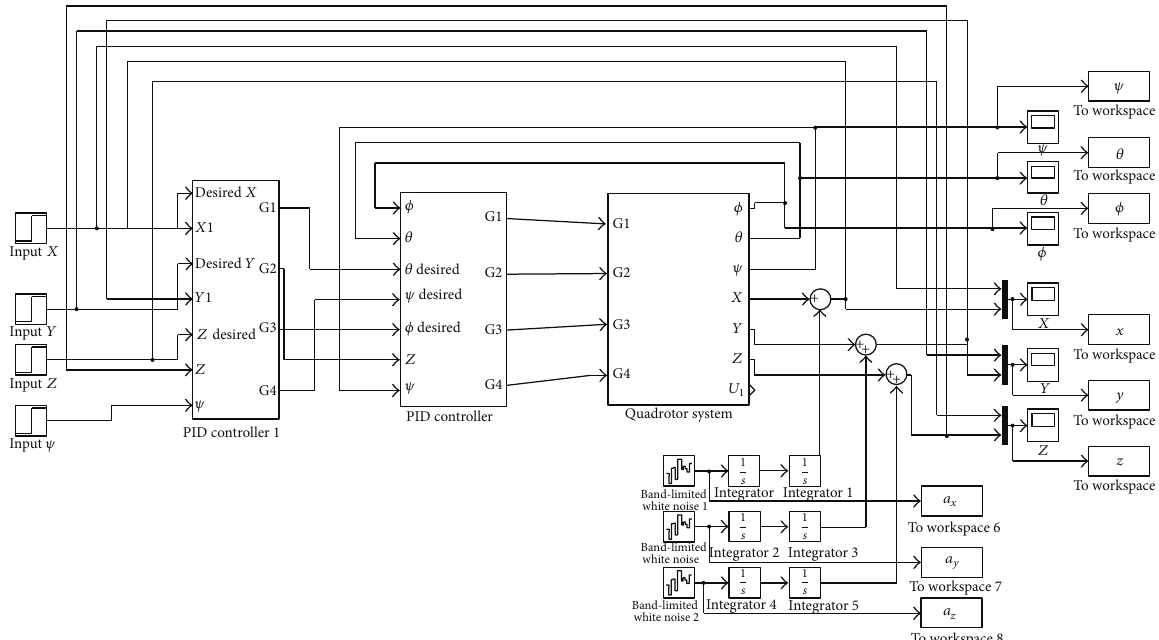
Figure 9: Implementation of the control system in MATLAB Simulink (full system).